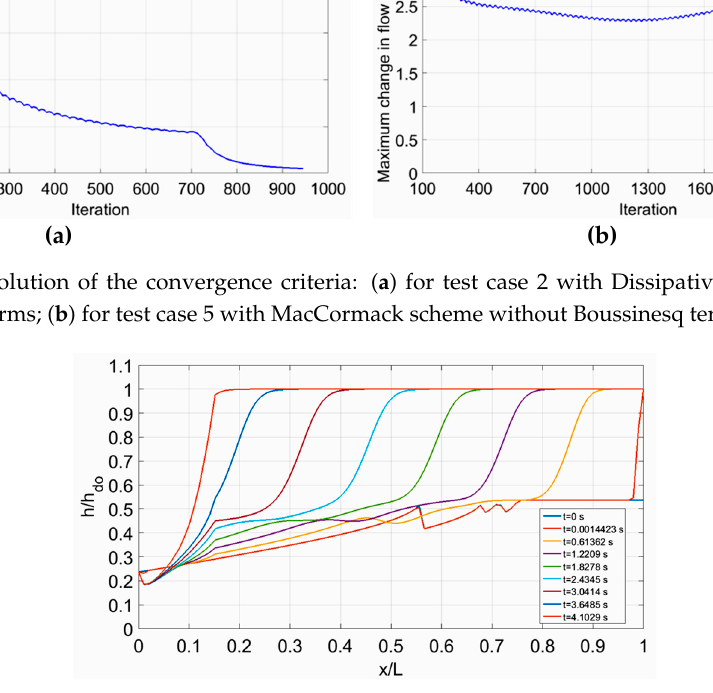
Figure 10. Temporal evolution of jump formation for test case 3 using the Dissipative two-four scheme including the Boussinesq terms.